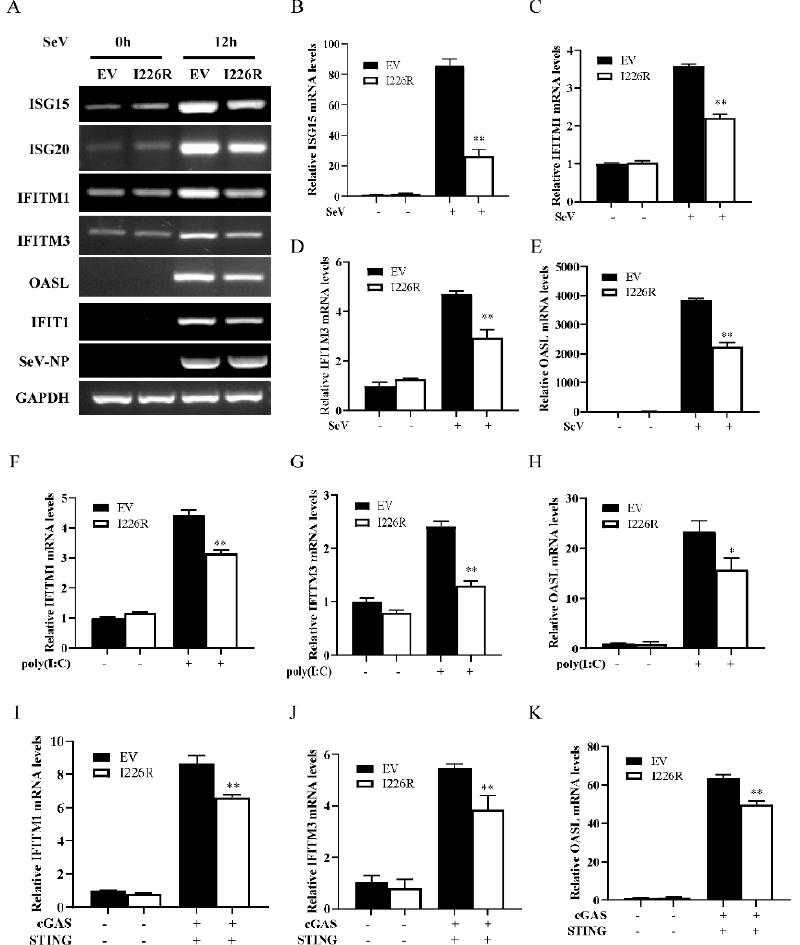
Figure 3. I226R-overexpressing cells have impaired expression of several critical ISGs. ( A – E ) 293T cells were transfected with 3 µ g I226R-Flag plasmid or EV for 24 h; then, they were infected with SeV for 12 h. RT-PCR ( A ) and RT-qPCR analysis ( B – E ) were performed to examine the mRNA levels of ISG15 ( B ), IFITM1 ( C ), IFITM3 ( D ), and OASL ( E ). ( F – H ) 293T cells were transfected with 3 µ g I226R-Flag plasmid or EV for 24 h; then, they were transfected with 1 µ g/mL of poly(I:C) for 12 h. RT-qPCR analysis was performed to examine the mRNA levels of IFITM1 ( F ), IFITM3 ( G ), and OASL ( H ). ( I – K ) 293T cells were co-transfected with 2 µ g I226R-Flag plasmid or EV and 500 ng cGAS-Flag and 100 ng STING-HA plasmids. RT-qPCR analysis was then performed to examine the mRNA levels of IFITM1 ( I ), IFITM3 ( J ), and OASL ( K ) 24 h later. The results are expressed as the means ± standard deviation from three independent experiments. Statistical analysis was performed using the Student’s t -test. * p < 0.05; ** p <